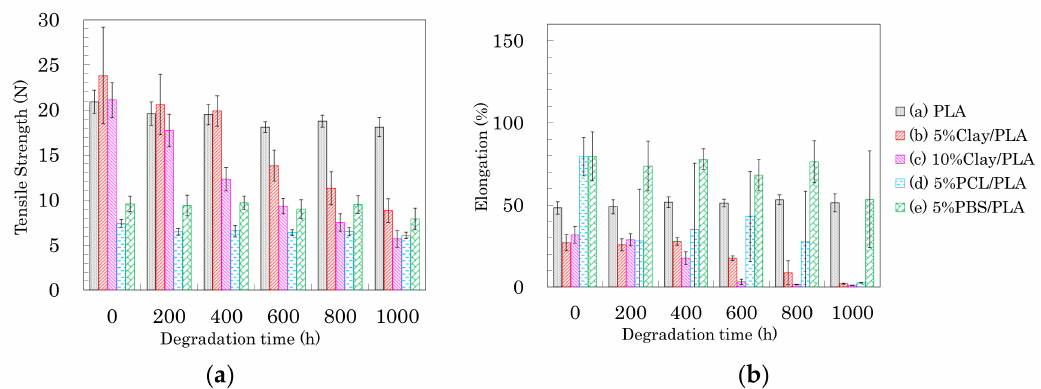
Figure 14. Tensile strength ( a ) and elongation ( b ) of 6 DR PLA fibers plotted versus degradation time.